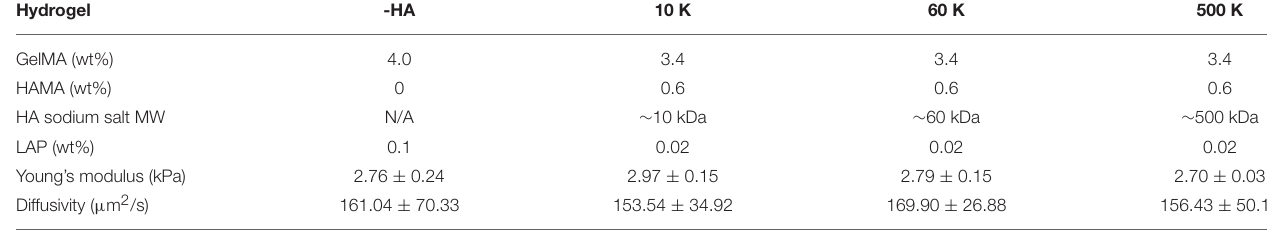
TABLE 1 | Hydrogel composition and characterization results ( n Hydrogel